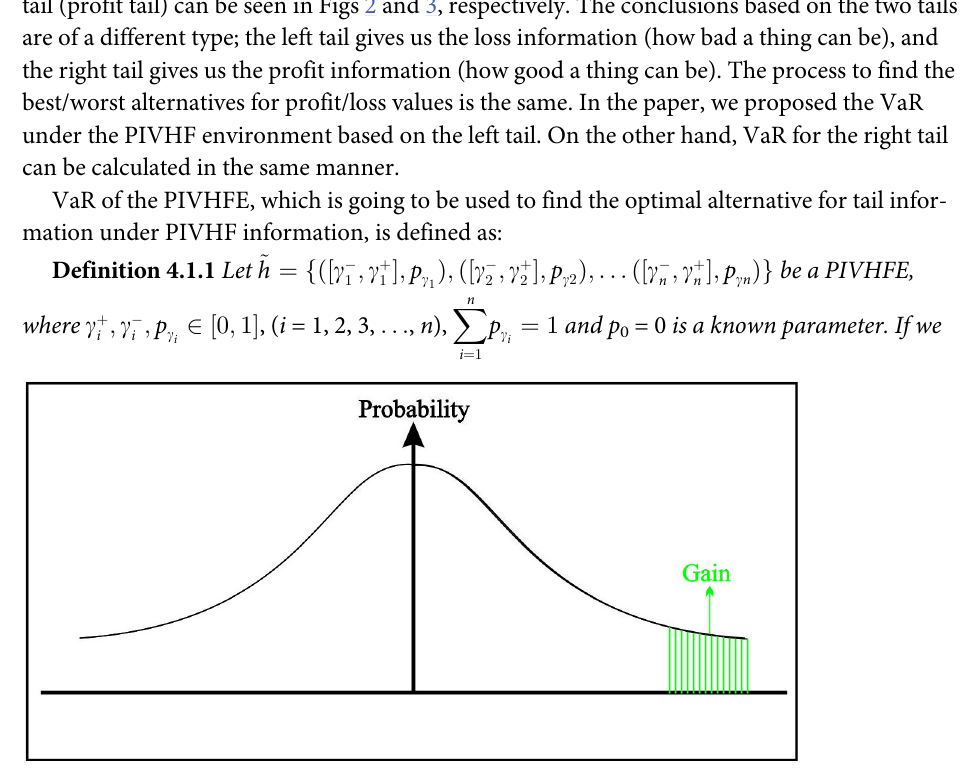
Fig 3. TDM based on the gain tail under PIVHF